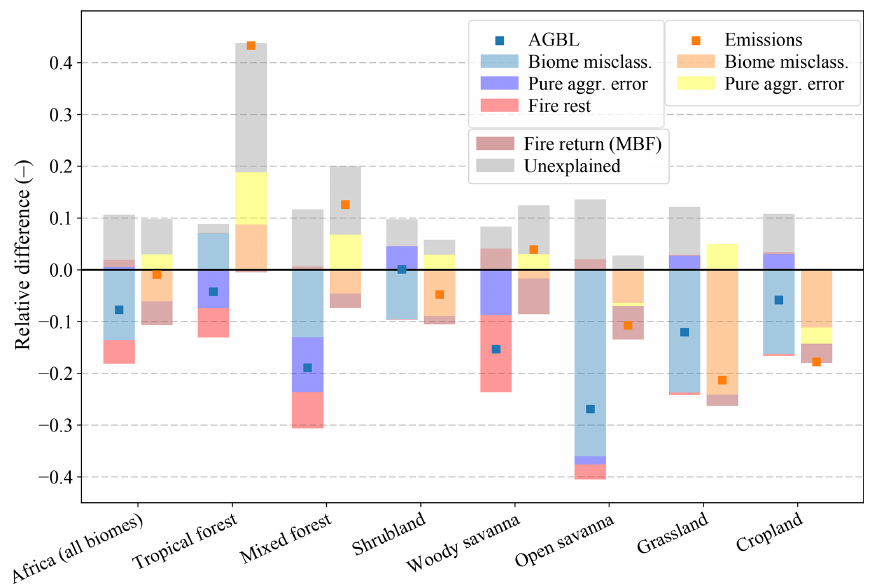
Figure 10. Relative simulation difference in AGBL and fire emissions for sub-Saharan Africa and for individual biomes, as the natural logarithm of the 0.25 ◦ model result over the 500m model result. Stacked bars depict the contribution of various error mechanisms to the overall resolution difference in AGBL and fire emissions by successive isolation of the biome-specific parameter error, the input aggregation error, the MBF, and finally the remaining difference related to fire (“Fire rest”). Furthermore, the unexplained remainder after removal of all identified mechanisms is shown